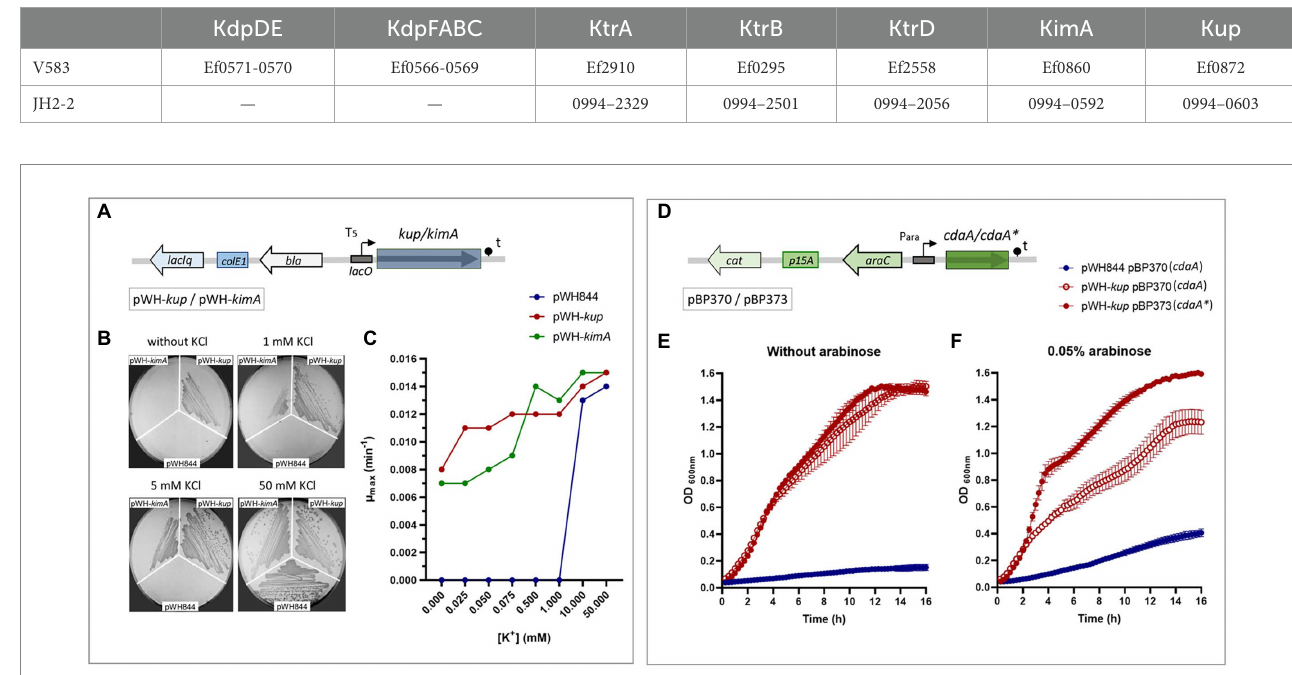
FIGURE 2 KimA and Kup of Enterococcus faecalis are potassium transporters. (A) pWH844 derived carrying full copy of Kup (pWH- kup ) or KimA (pWH- kimA ) used in this study. (B) Escherichia coli LB650 strains harboring plasmids pWH844, pWH- kup , and pWH- kimA were grown in M9-mod solid medium with or without supplementation of KCl (1, 5, or 50 mM). (C) Growth rate parameters determined at different KCl concentrations of LB650 derived strains, pWH844 (blue dot), pWH- kup (red dot), and pWH- kimA (green dot). Inhibition of Kup activity by c-di-AMP (D) pBAD derived carrying a copy of cdaA lmo (pBP370) or cdaA lmo * (pBP373) used in this study. (E,F) Escherichia coli LB2003 harboring the plasmid combinations pWH844/pBP370 (blue dot), pWH- kup /pBP370 (empty red dot), and pWH- kup /pBP373 (full red dot), was cultivated in minimal salt M9mod medium, and supplemented without arabinose (E) or with arabinose 0.05% (F)